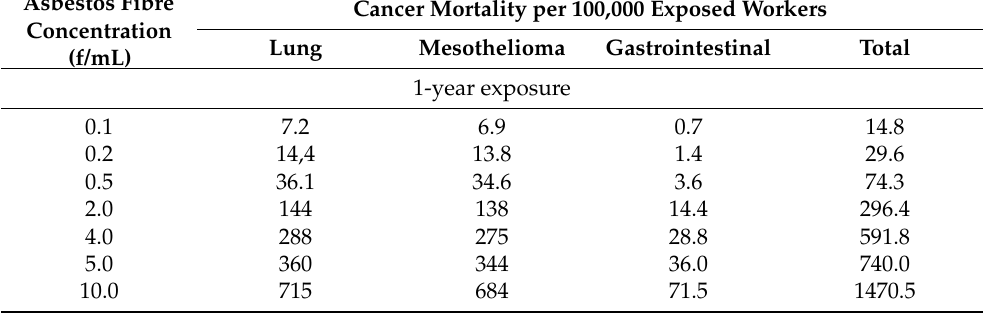
Table 1. Estimates of asbestos-related cancer mortality per 100,000 exposed workers by number of years exposed and exposure